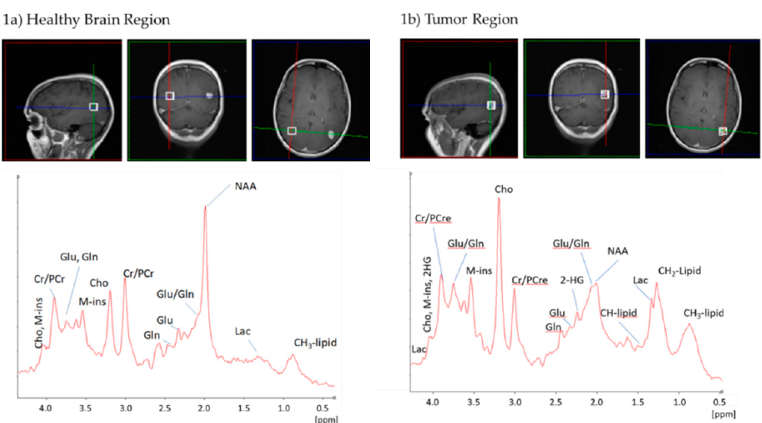
Figure 1. Exemplary 1 H-magnetic resonance spectra ( 1 H-MRS) of a glioma patient bearing an IDH mutation. Both spectra were acquired by a 3T MR scanner in a voxel of 14 × 14 × 14 mm. ( a ) healthy brain region ( b ) tumor region.Abbreviations: 2-HG, D-2-hydroxyglutatrate; CH2-Lipid, CH2 groups of lipids; CH3-Lipid, CH 3 groups of lipids; Cho, choline; Cr, creatine; Gln, glutamine; Glu, glutamate; Lac, lactate; M-ins, myo-inositol; NAA, N-acetylaspartate; PCr,